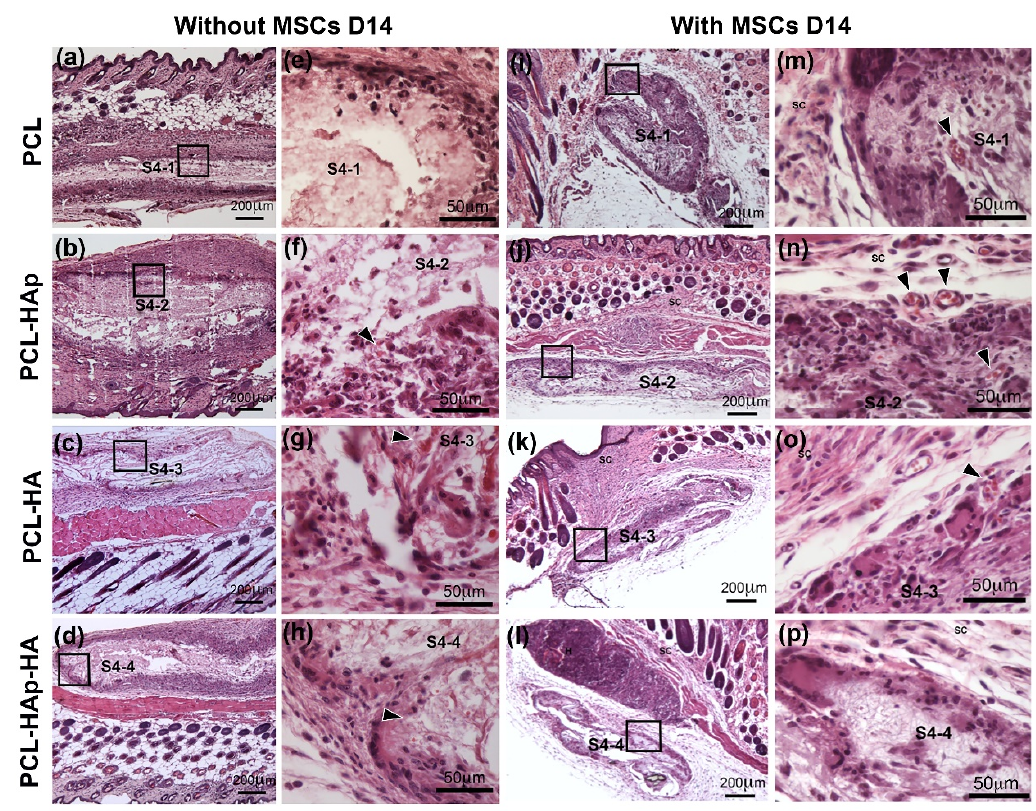
Figure 6. Haematoxylin-Eosin (HE) staining for PCL, PCL-HAp, PCL-HA, and PCL-HAp-HA scaffolds subcutaneously implanted for 2 weeks without cells in ICR mice ( a – h ) and with hBM-MSCs in nude mice ( i – p ). S4-1 in ( a , e , i , m ) for the PCL scaffold; S4-2 in ( b , f , j , n ) for the PCL-HAp scaffold; S4-3 in ( c , g , k , o ) for the PCL-HA scaffold; and S4-4 in ( d , h , l , p ) for the PCL-HAp-HA scaffold. Black arrowheads indicate vascularization. Black squares indicate the enlarged areas.